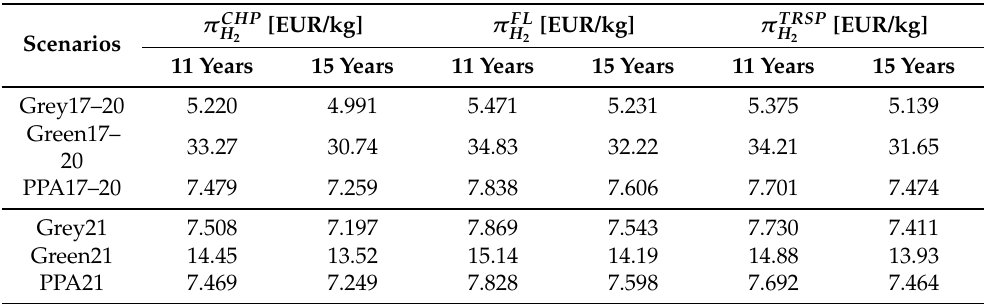
Table 7. H 2 prices for each client to reach a payback period of 11 years and 15